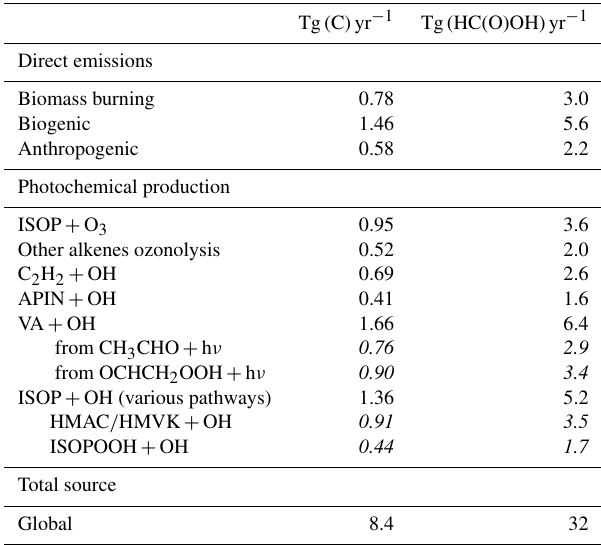
Table 5. Global sources of HC ( O ) OH in the model simulation. Ro- man font is used for the main sources, whereas subtotals are shown in italic